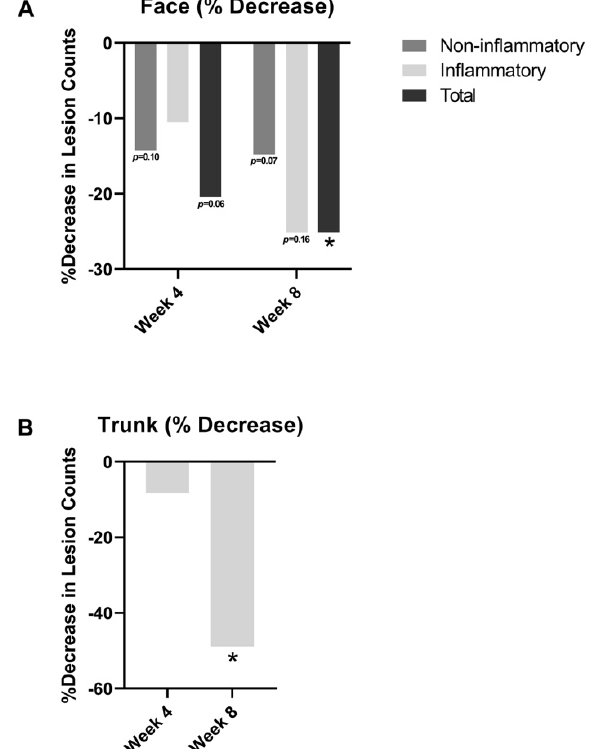
Figure 2. ( A ) Facial acne lesion counts and truncal lesion counts; ( B ) truncal acne inflammatory lesion counts at week 4 and week 8 relative to baseline. * = p < 0.05.